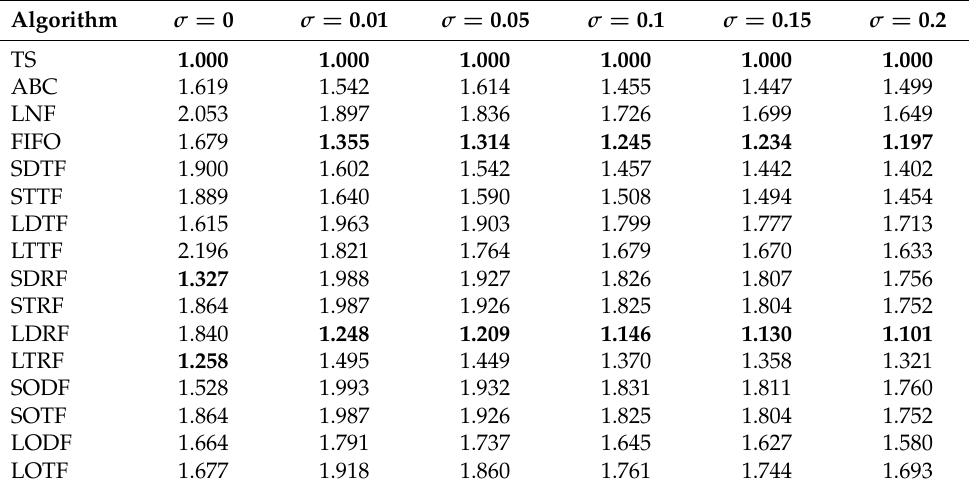
Table 3. PRD results for instance no. 48 ( n = 6) with 546 sectors and 2415 resources (best three results for each scenario type in